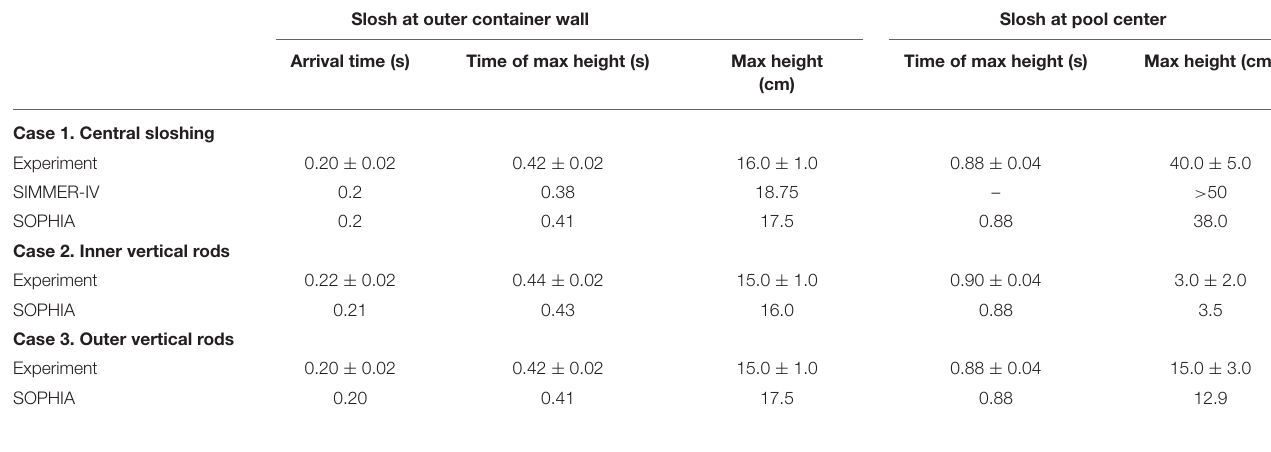
TABLE 4 | Comparison of SOPHIA simulation with experiments (Maschek et al., 1992b; Pigny,